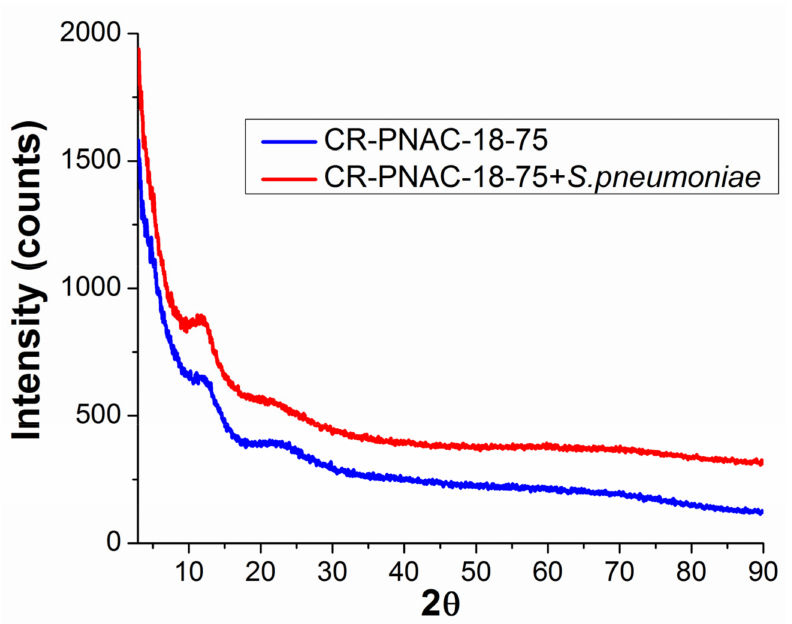
Figure 5. X-ray diffractogram (XRD) patterns of CR-PNAC-18-75 before ( red ) and after incubation with S. pneumoniae ( blue